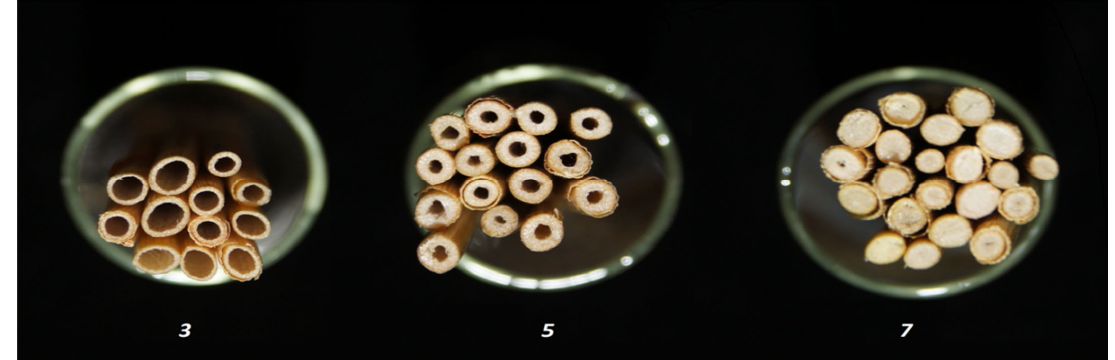
Figure 1. The assessment of the stem-solidness according to the methodology recommended by the UPOV: 3—thin pith = hollow, 5—intermediate pith, 7—thick pith = solid (Photo by M. Pluta).